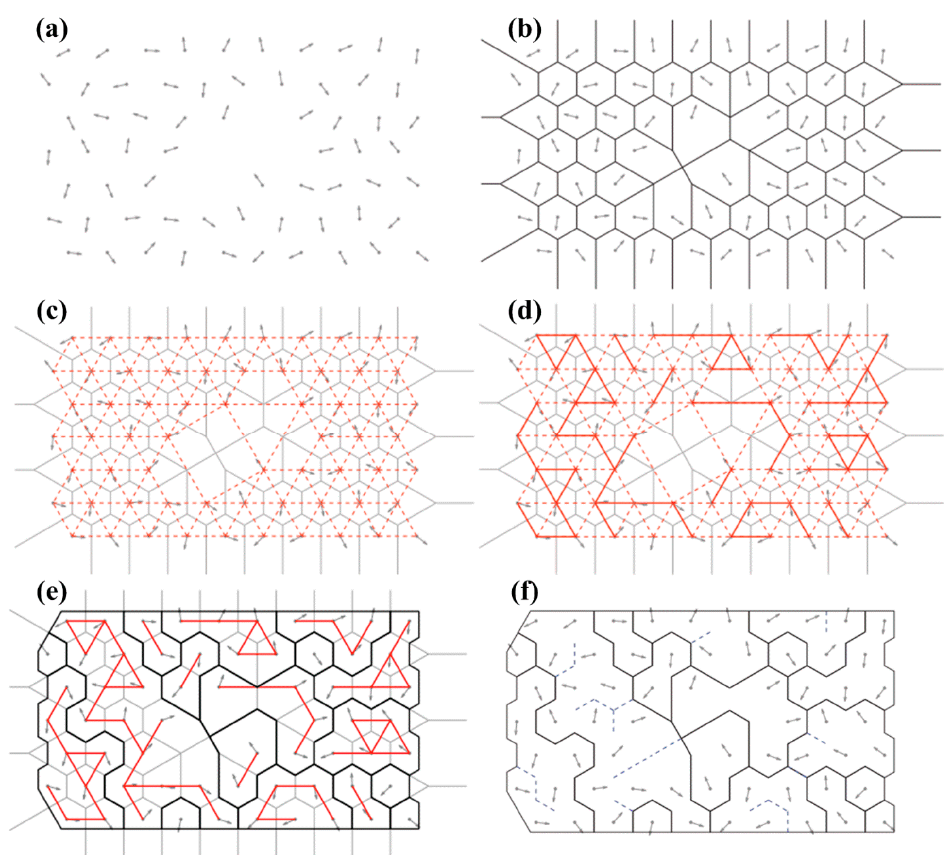
Figure 2. Schematic diagram of the grain structure reconstruction algorithm [36]. ( a ) The orientation data, ( b ) the Voronoi decomposition of the inspection locations, ( c ) the neighborhood relationships of Voronoi cells, ( d ) adjacent Voronoi cells that are not separated by a grain boundary ( e ) adjacent Voronoi cells that are separated by a grain boundary and ( f ) resulting partition displaying grain boundaries.